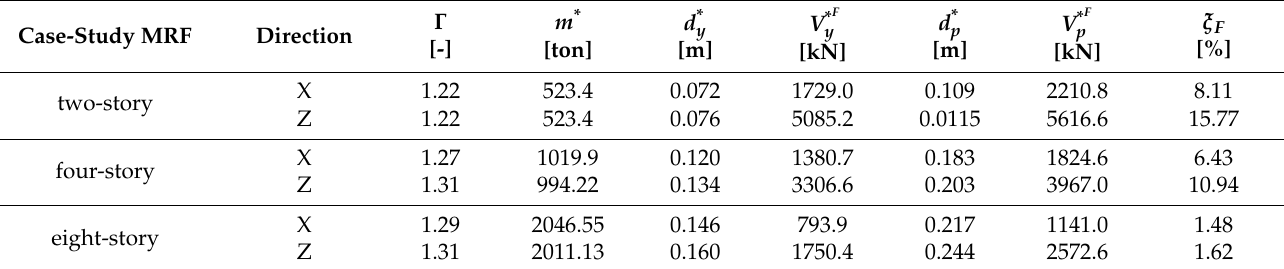
Table 2. Properties of the equivalent SDOF systems of case-study MRFs.